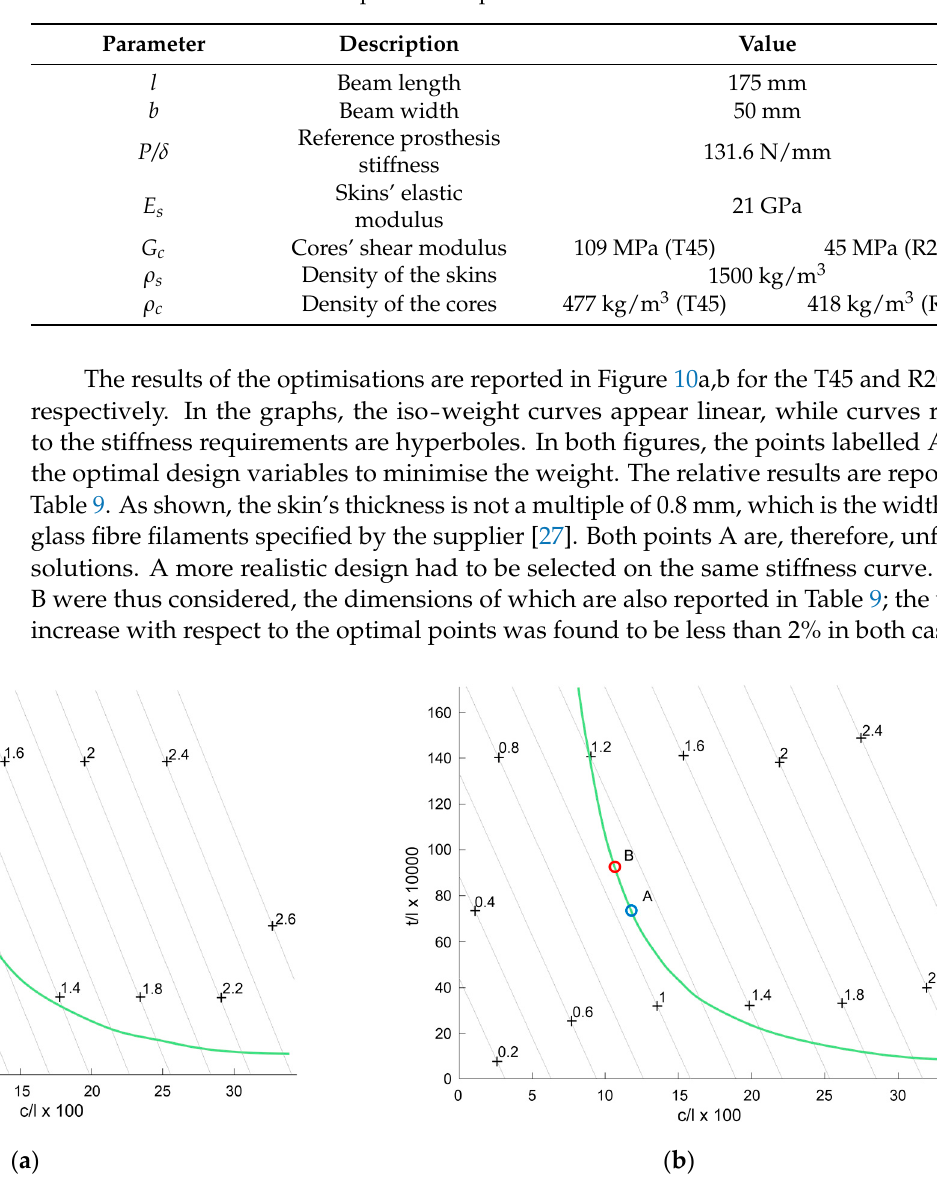
Table 8. Parameters used in the optimisation procedure.